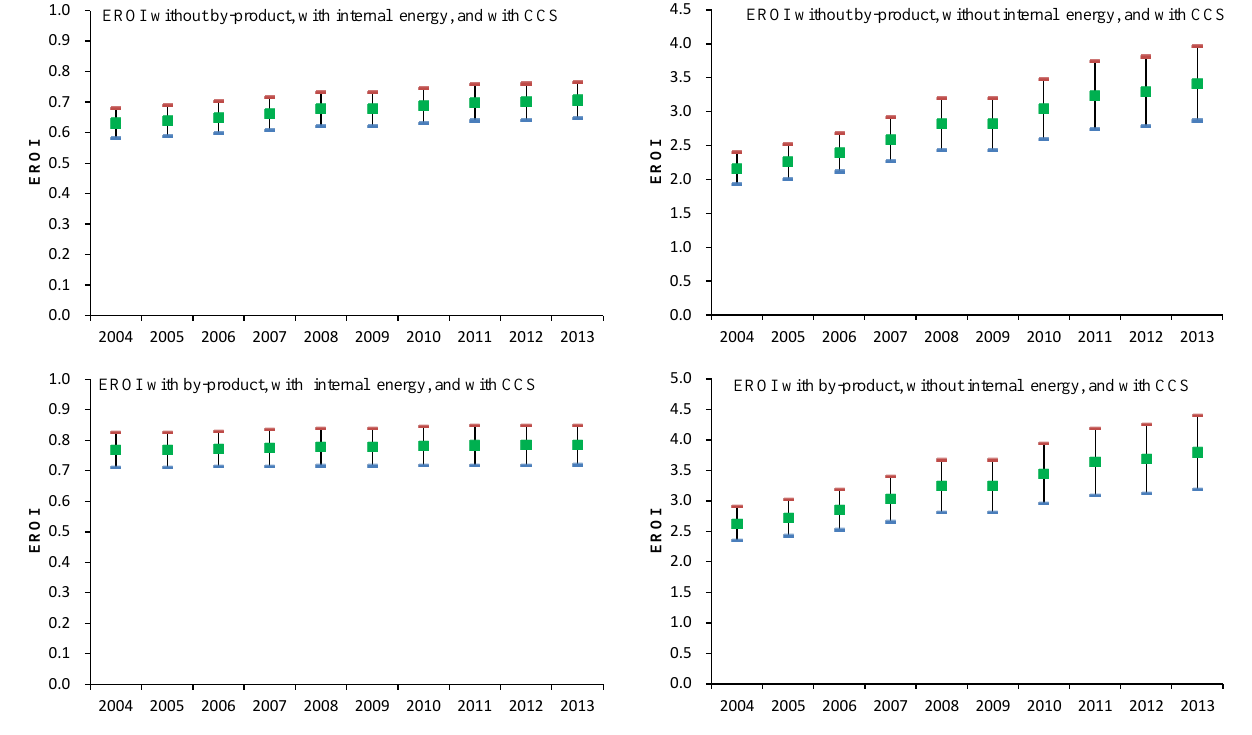
Figure 8. The change of EROI with CCS caused by the varying energy